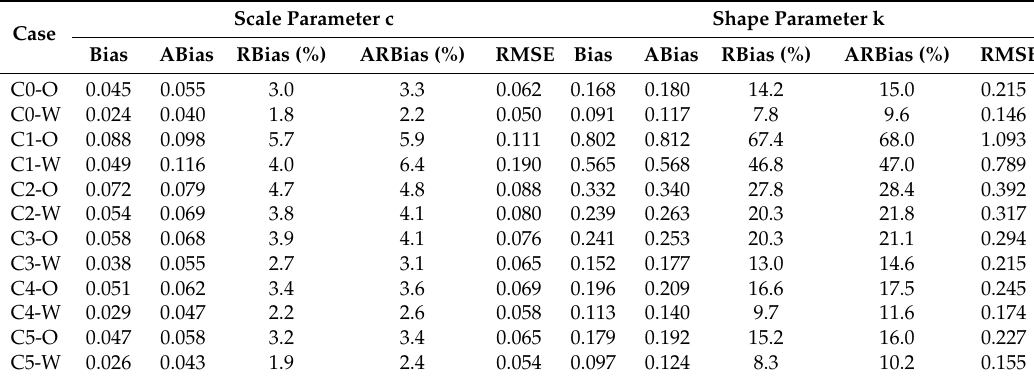
Table 7. Means of the evaluation criteria for the downscaled Weibull parameter estimates based on parameter estimates of the observed Weibull distribution of all the stations from the test